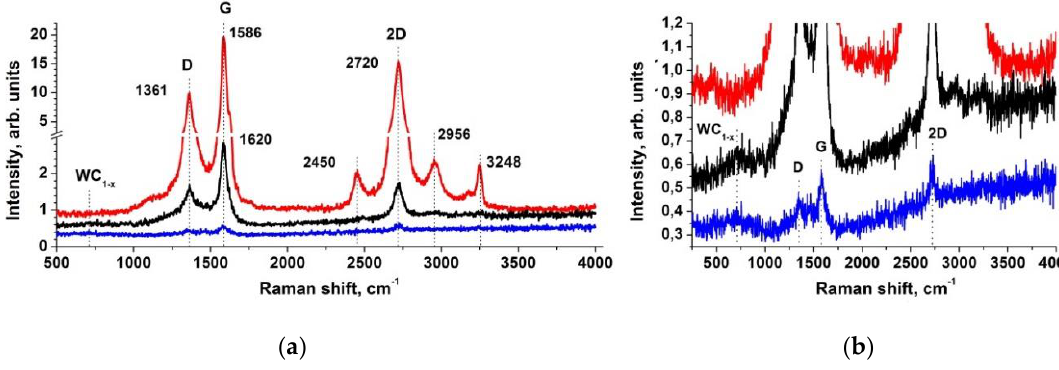
Figure 5. The Raman spectra in wide ( a ) and narrow ( b ) energy range of the initial MWCNTs (red), (pyrolytic tungsten)/MWCNT nanocomposite sample 2 (black) and sample 3